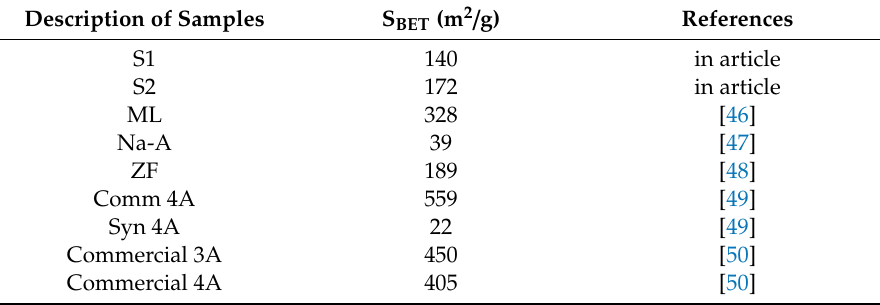
Table 6. The specific surface area of obtained materials and synthetic zeolites of type A. Description of